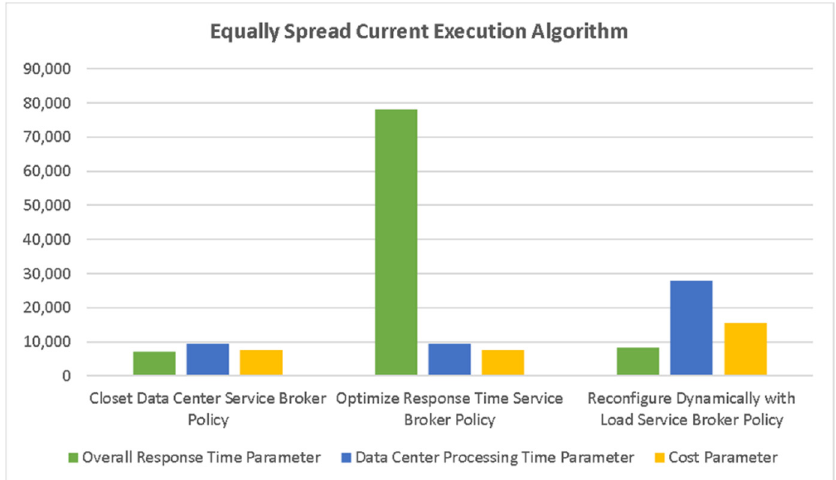
Figure 13. The analysis of the performance parameters of the ESCE algorithm on 3 service broker policies.